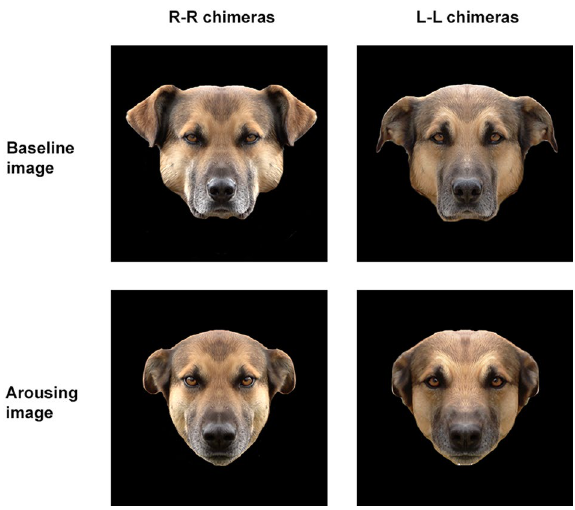
Figure 3. Chimeric pictures. Composite photographs displaying right-right (RR) and left-left (LL) chimeric facial expressions for baseline and arousing emotional